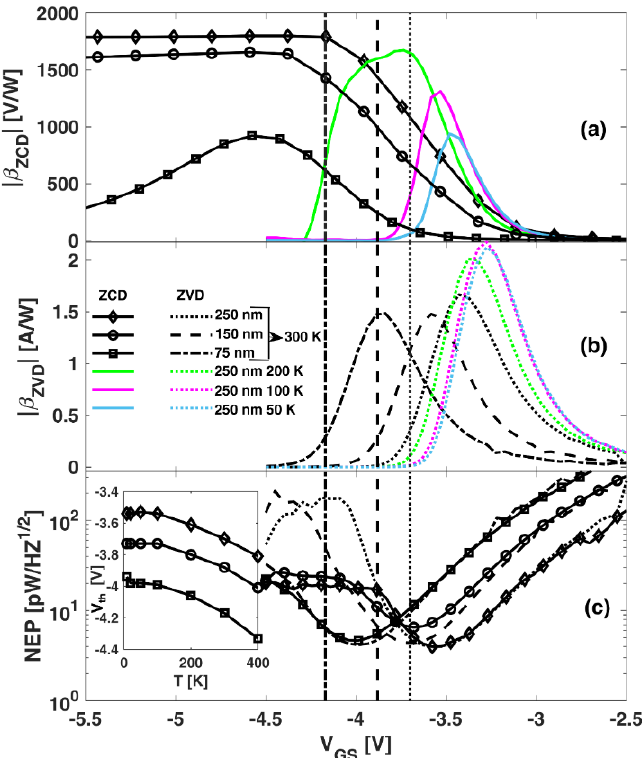
Figure 2. ( a ) ZCD and ( b ) ZVD responsivities as a function of 𝑉 𝐺𝑆 for transistors with different 𝐿 𝐺 values measured at several T . ( c ) Corresponding NEP s at 300 K. The inset in ( c ) shows 𝑉 𝑡ℎ of the transistors as a function of T , determined at 𝑉 𝐷𝑆 = 0.1 V. The vertical lines indicate the value of 𝑉 𝑡ℎ for the different gate lengths at 300 K.